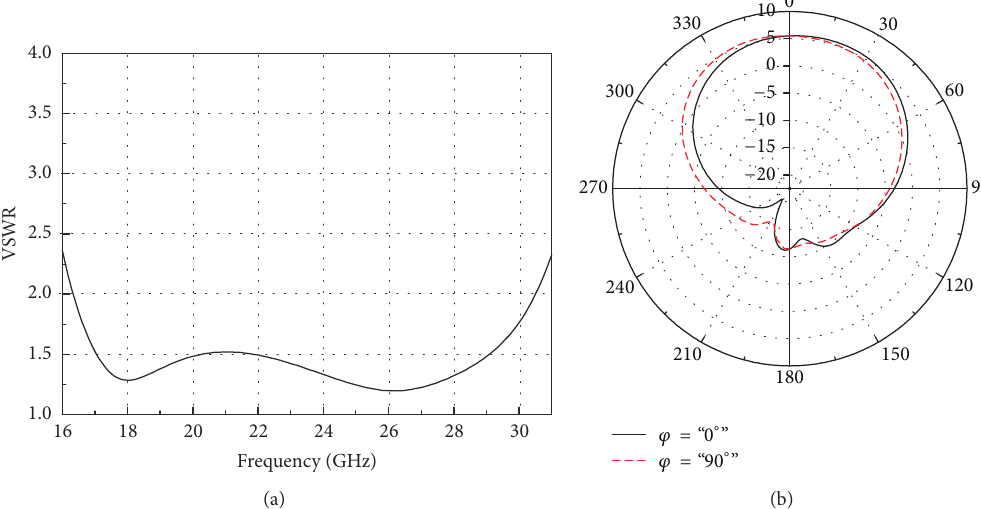
Figure 5: (a) VSWR of slant polarized IMF-CBSA element obtained in the simulation; (b) radiation pattern of slant polarized IMF-CBSA element obtained in the